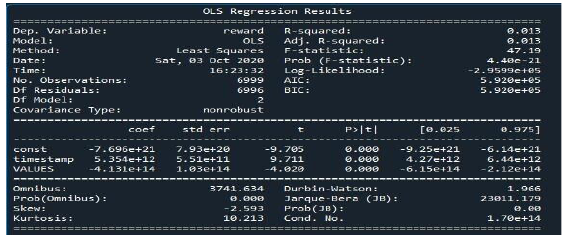
Fig 3. OLS Regression